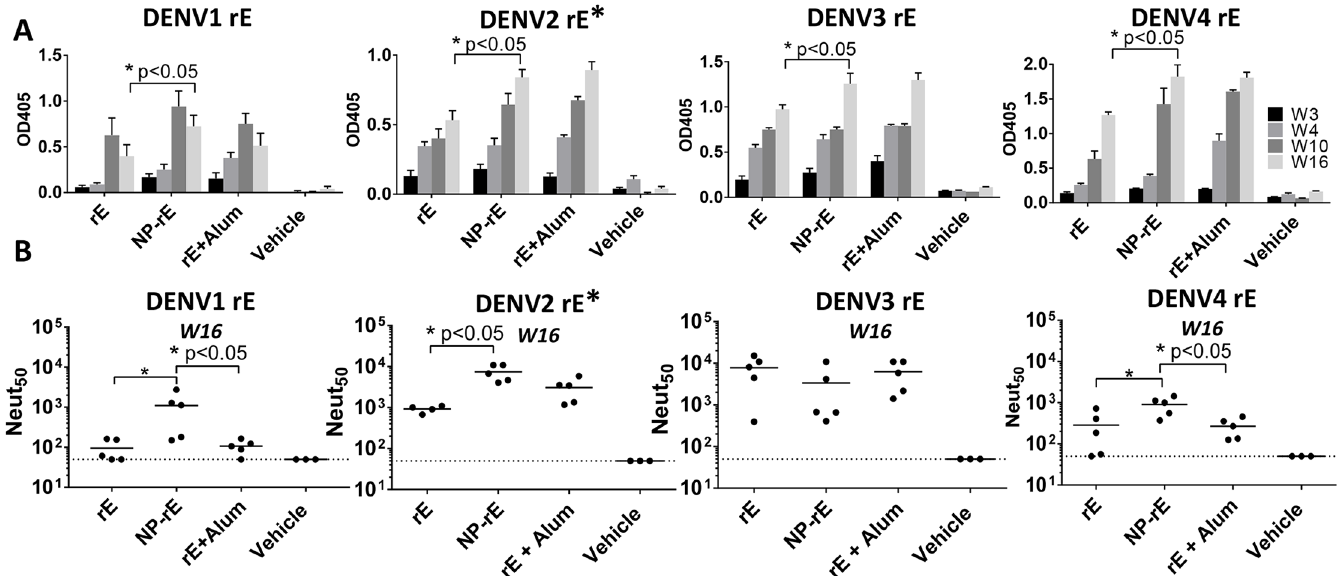
Fig 3. Monovalent NP-rE formulations induce robust neutralizing antibody titers. A) DENV1-4 specific IgG titers were determined for week 3, 4, 10 and 16. B) The neutralizing activity of the mice sera at week 16 was determined with a neutralization assay where DENV is incubated with serially diluted mice sera and subsequently allowed to infect Vero-cells. Neutralizing activity was expressed as the dilution where 50% of the virus was neutralized (Neut 50 ). (cid:3) DENV2 data adapted from previously published data [15]. Statistical differences were determined by one-way ANOVA followed by Tukeys test (p < 0.05).